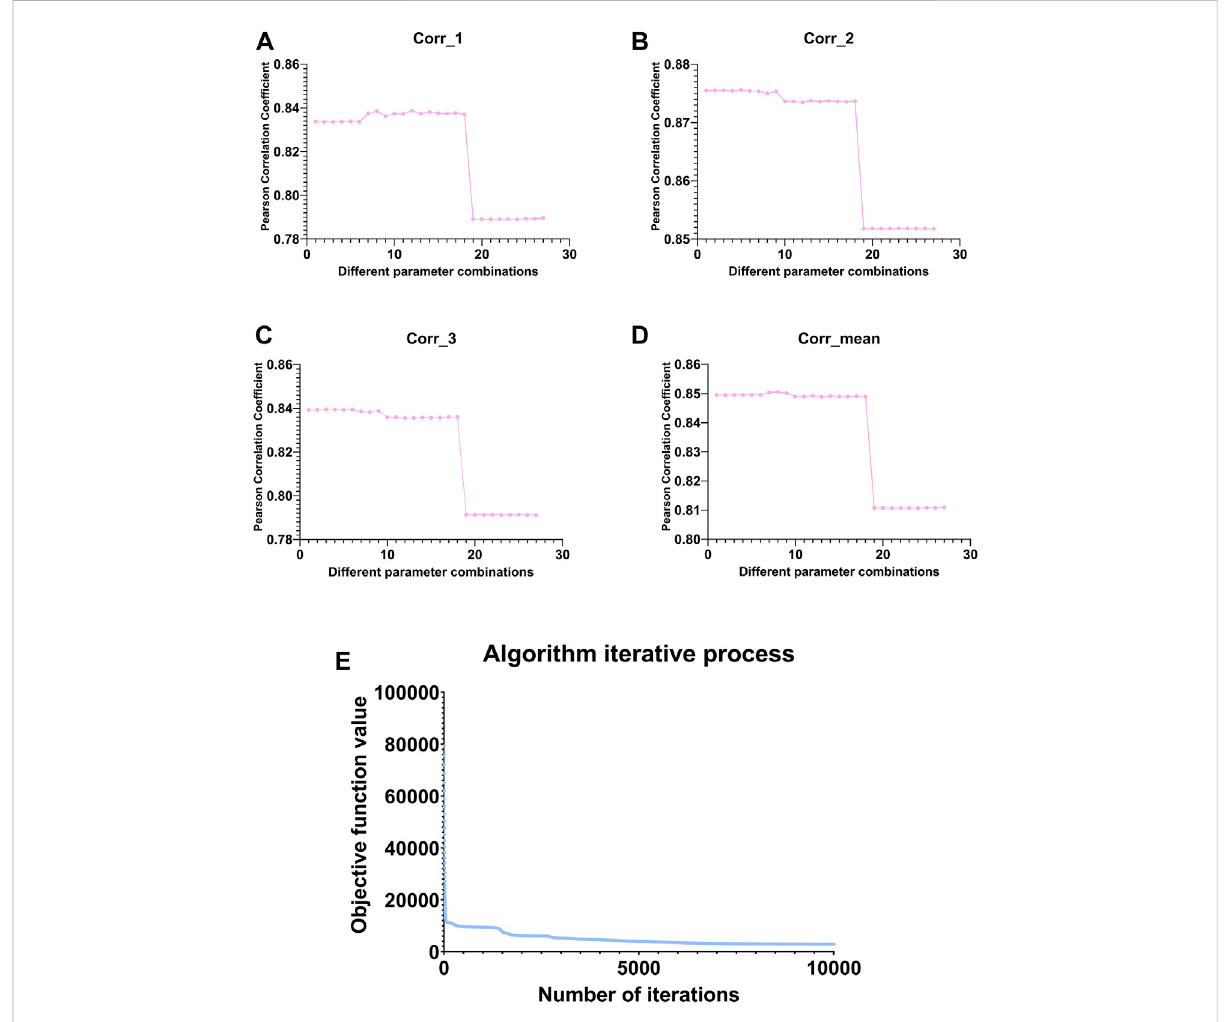
FIGURE 3 Line graph of the change in Pearson correlation coef fi cient between the original and reconstructed matrices under different parameter combinations. (A – C) represent the variation of the Pearson correlation coef fi cient between X i and UH i respectively. (D) represents the mean of these three data under different parameter combinations. The circled point in each subplot represents the maximumvalueofthePearsoncorrelationcoef fi cientforthegroup. (E) representsthechangingtrendofthealgorithm ’ sobjectivefunctionwith the increase of the number of iterations in the training process under the optimal